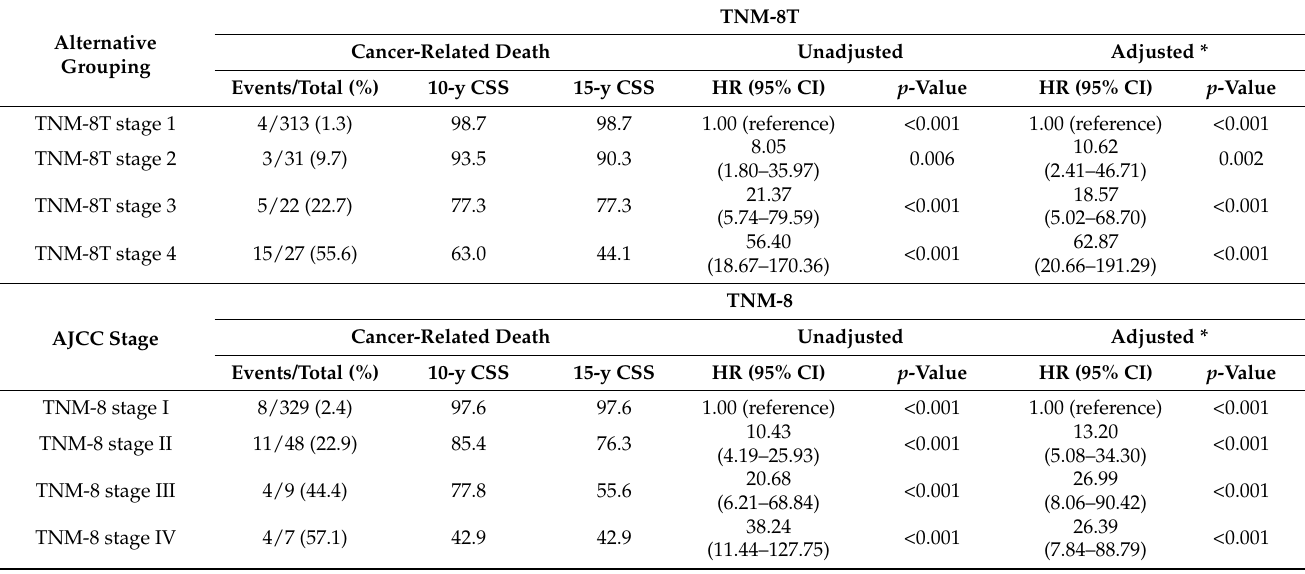
Table 4. Hazard ratios of TNM-8T and TNM-8 for cancer-related